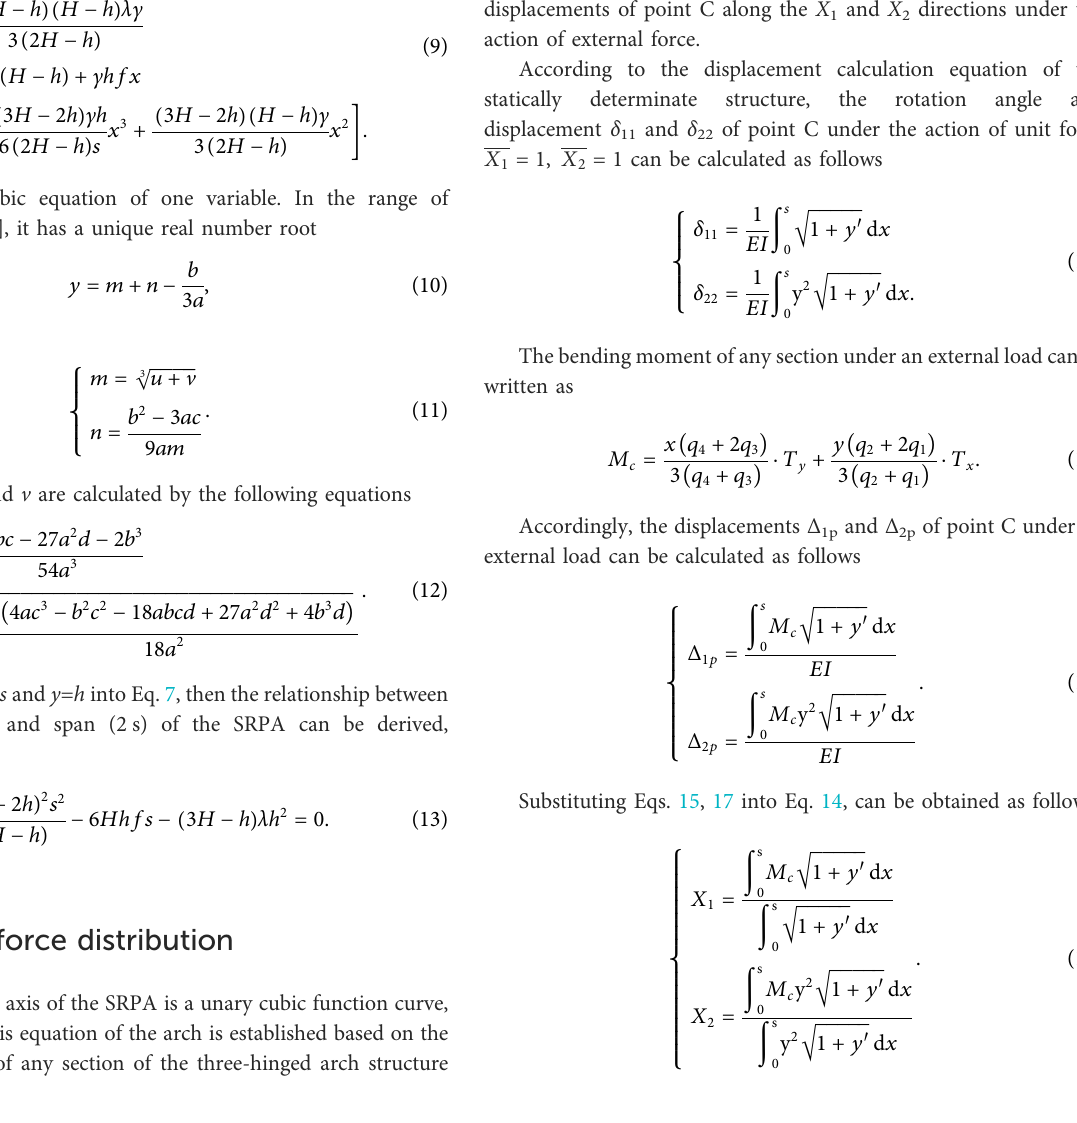
unknown forces X 1 , X 2, and X 3 in the cross section, which are the bending moment, axial force and shear force respectively. Due to the symmetry of the structure and load, the antisymmetric internal shear force on the central section is 0, that is X 3 =0. X 1 , and X 2 can be solved according to the force method equations.